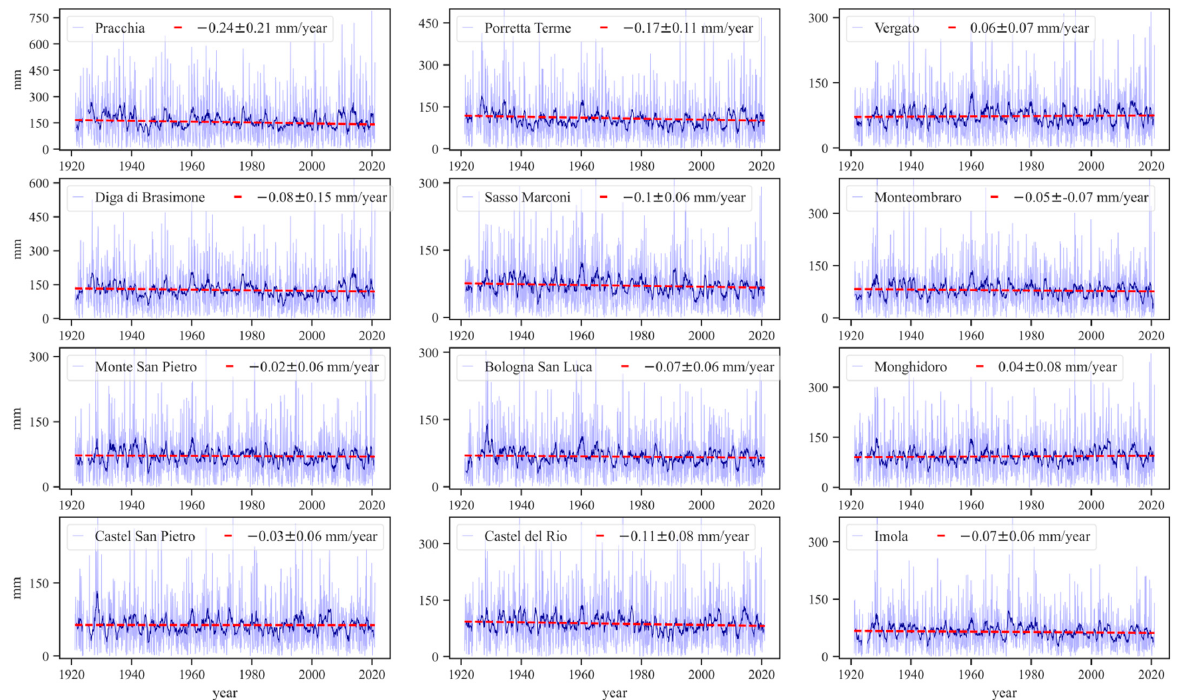
Figure A3. Rainfall time series, and related linear trends, for the twelve rain gauge stations considered in this work (see Figure 1 for locations).